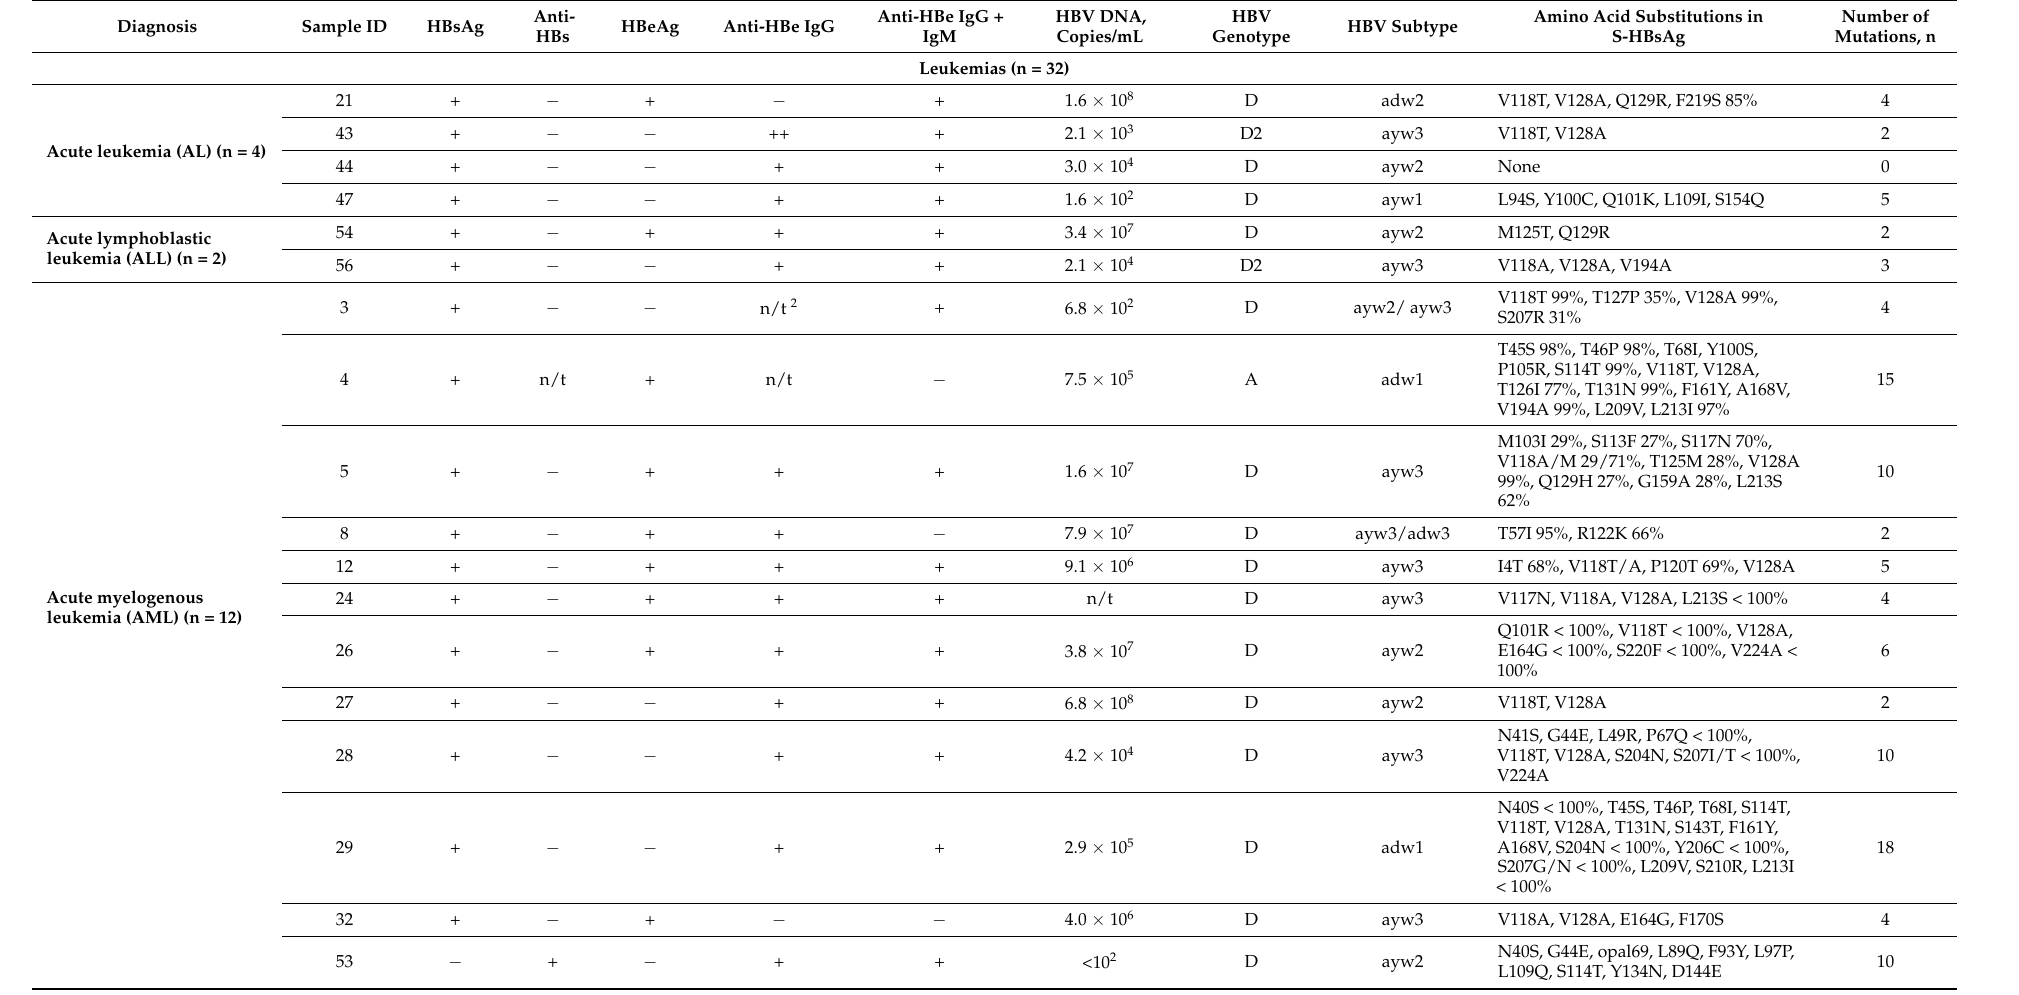
Table 1. Serological and genetic characteristics of HBV in 59 isolates from patients with hepatitis B and hematologic diseases 1